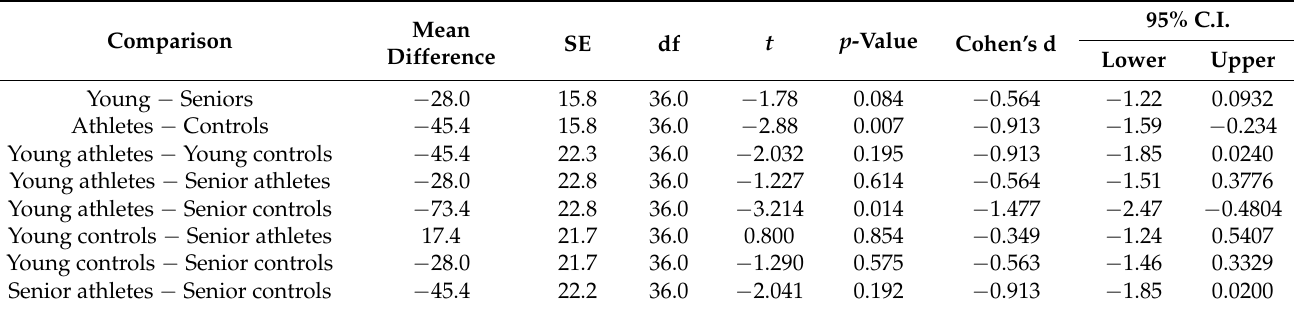
Table 4. ANOVA results for ground contact